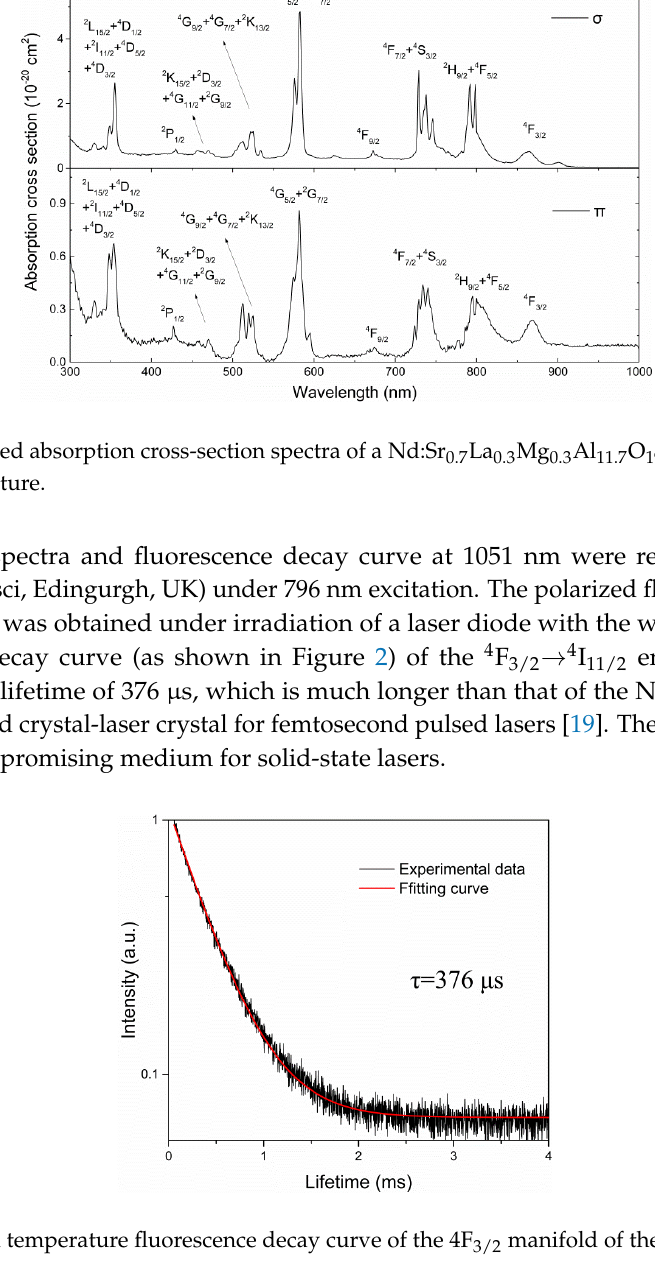
Figure 2. Room temperature fluorescence decay curve of the 4F 3/2 manifold of the Nd:ASL